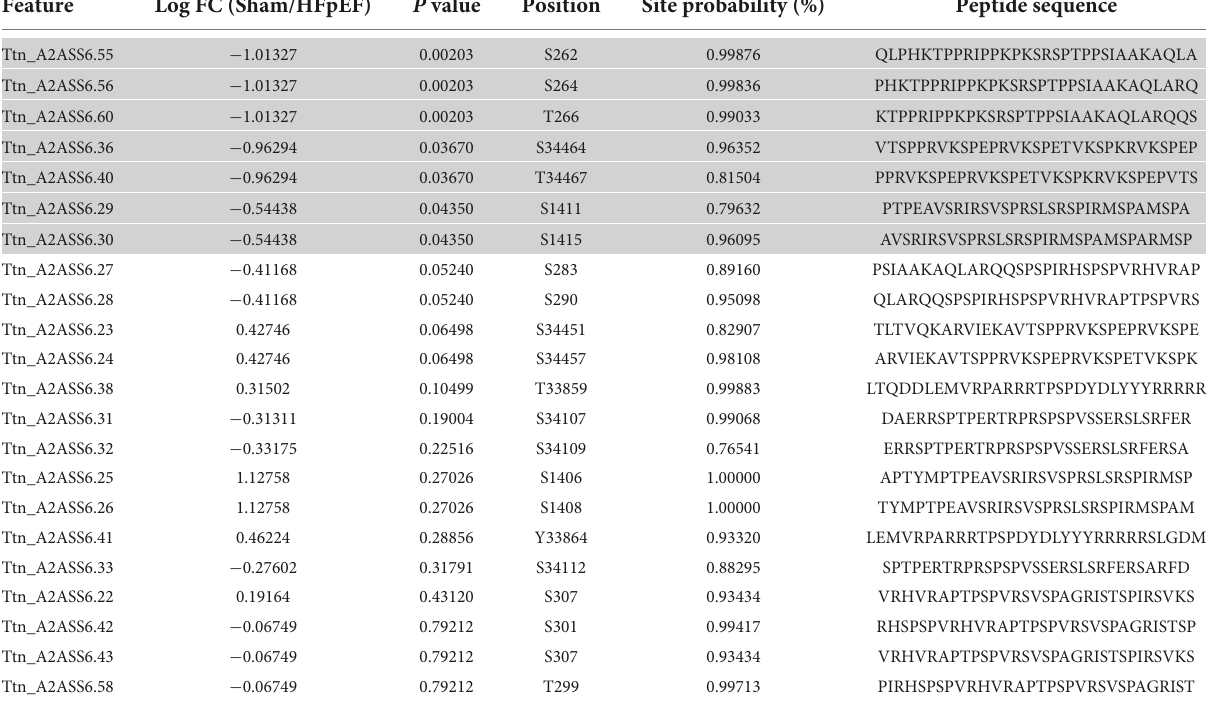
TABLE 4 Significantly changed titin